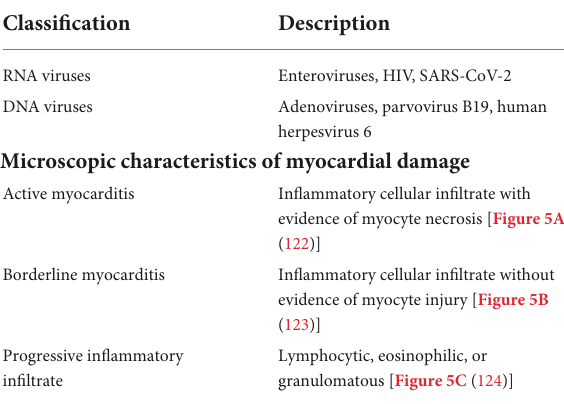
TABLE 1 Main viruses and some microscopic characteristics of myocardial damage.